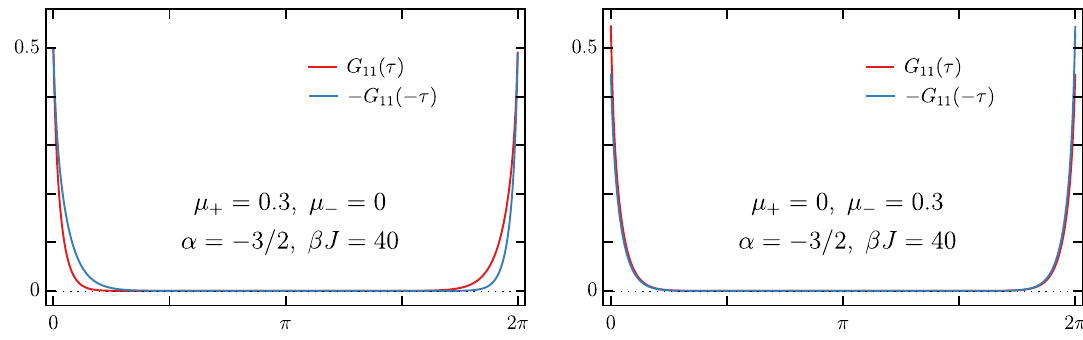
Figure 7 . Plots of the Green functions when chemical potentials are turned on. For µ + 6 = 0 , G 22 ( τ ) = G 11 ( τ ) , while for µ − 6 = 0 , G 22 ( τ ) = − G 11 ( − τ ) . It follows that h Q − i is generated for µ − 6 = 0